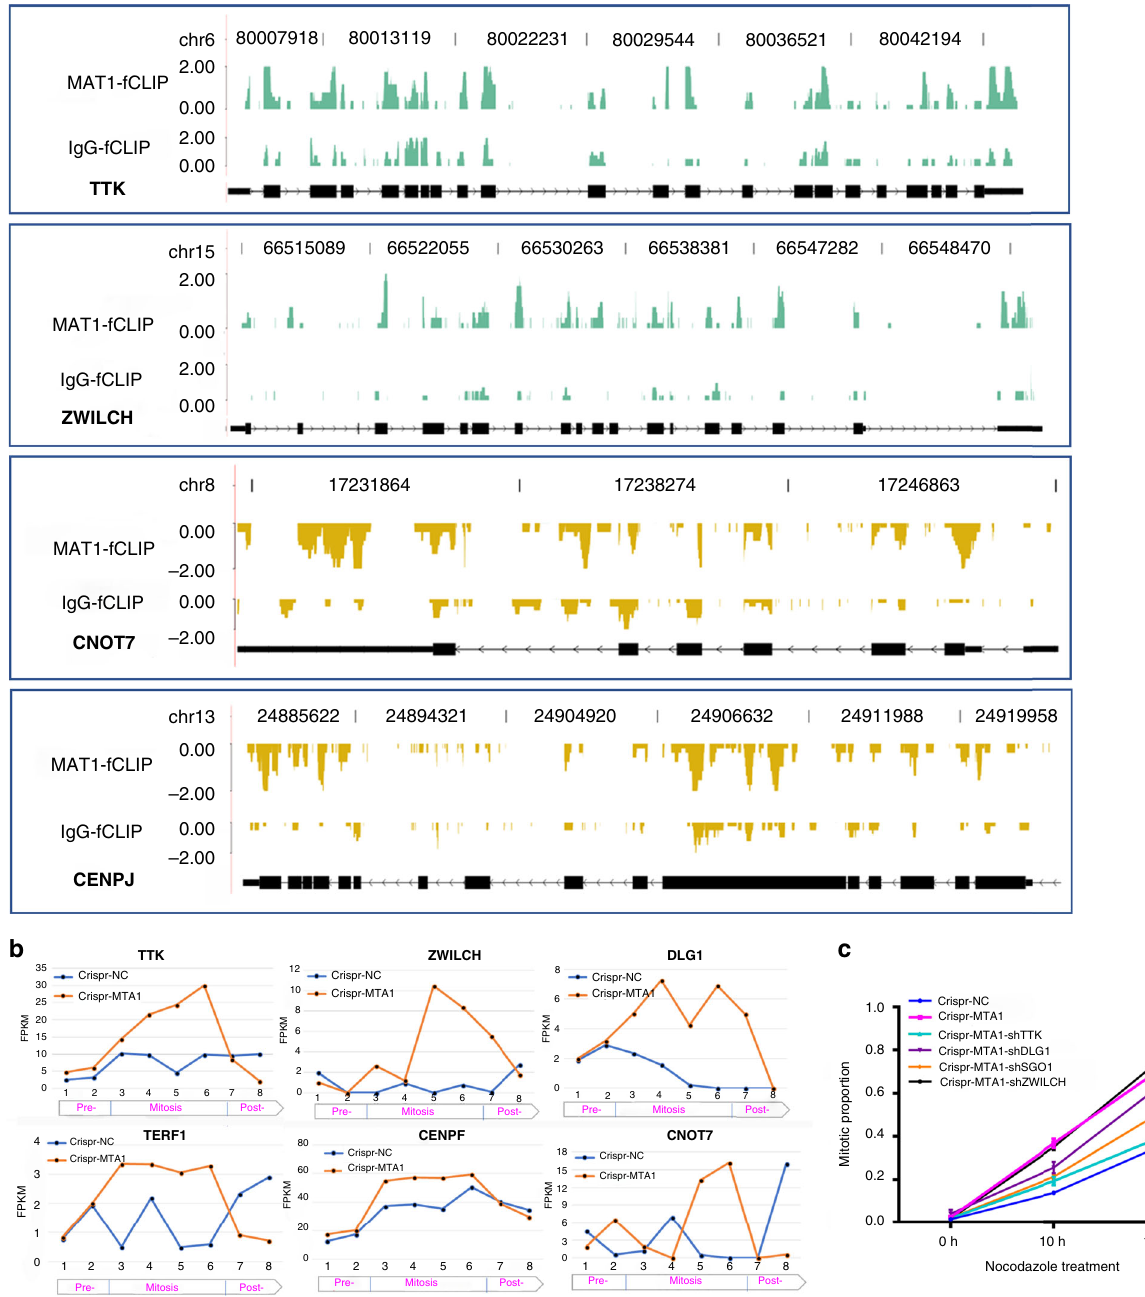
Fig. 5 MTA1 alters transcript abundance of mitosis regulators. a fCLIP-seq read density illustration showing the speci fi c binding of MTA1 to transcripts of mitosis regulators, such as TTK, ZWILCH, CNOT7 and CENPJ. b MTA1 deletion led to a signi fi cant alteration of MTA1-associated mitosis-regulator transcripts in mRNA abundance during mitosis. For TTK, ZWILCH, DLG1 TERF1 and CENPF, the alteration started speci fi cally after entry into the mitotic stage. While for CONT7, MTA1 deletion reversed the periodic fl uctuation trends across the cell cycle. c TTK, ZWILCH, SOG1 and DLG1 were knocked down in MTA1-knockout HCT116 cells, and then treated with nocodazole for 0 h, 10 h and 18 h. The mitotic cells were marked with p-H3 antibody and counted using high content analysis system. Data are represented as mean ± SD, n =